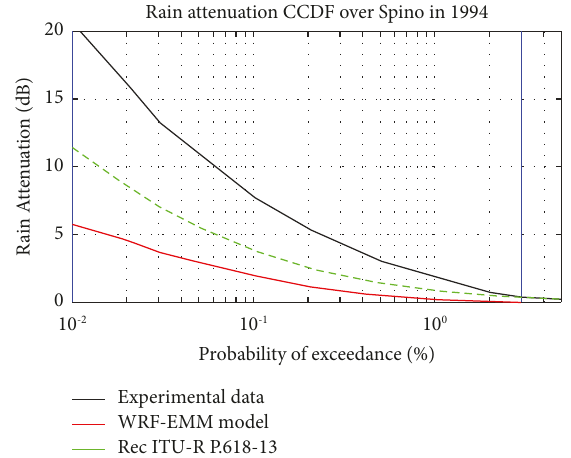
Figure 9: Comparisons between CCDFs computed from data measured in Spino d’Adda in 1994 (98.3% availability), WRF-EMM simulations and Rec. ITU-R P.618–13 using R 0.01 predicted with Rec. ITU-R The last comparison is achieved with respect to prop- agation data collected at 18.7 GHz in 1994 in Spino d’Adda.